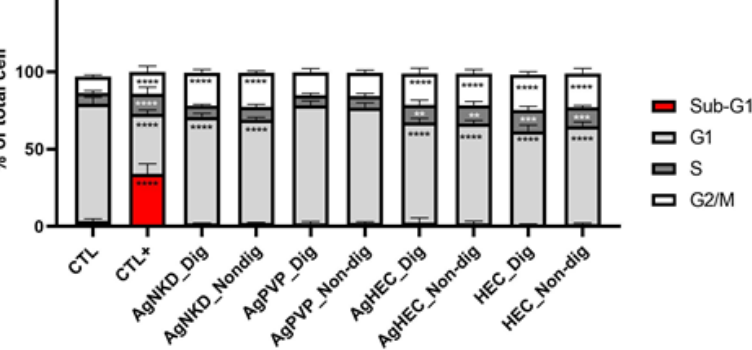
Figure 7. Analysis of cell cycle and distribution of cells in the G2, S, G0/G1 and sub-G1 phases. Cells were exposed to Ag NMs or to 0.3 µM of staurosporine (CTL+) for 24 h, then labelled with propidium iodide and analyzed by flow cytometry. Graph represents mean ± standard deviation for three independent experiments with three replicates per experiment. Statistical significance: (**) p <0.01, (***) p < 0.001, and **** p < 0.0001, exposed vs. control. G1: AgNKD vs. AgPVP, AgPVP vs. AgHEC, S: AgNKD vs. AgHEC, AgPVP vs. AgHEC, G2/M: AgNKD vs. AgPVP, AgPVP vs. AgHEC, all (****) p < 0.0001.